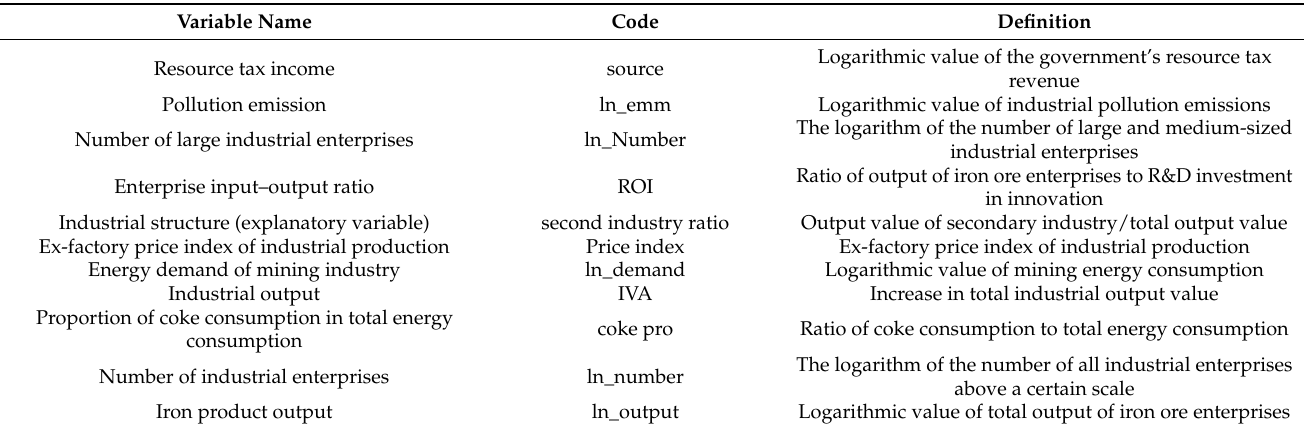
Table 1. Variable definition and interpretation 1 .